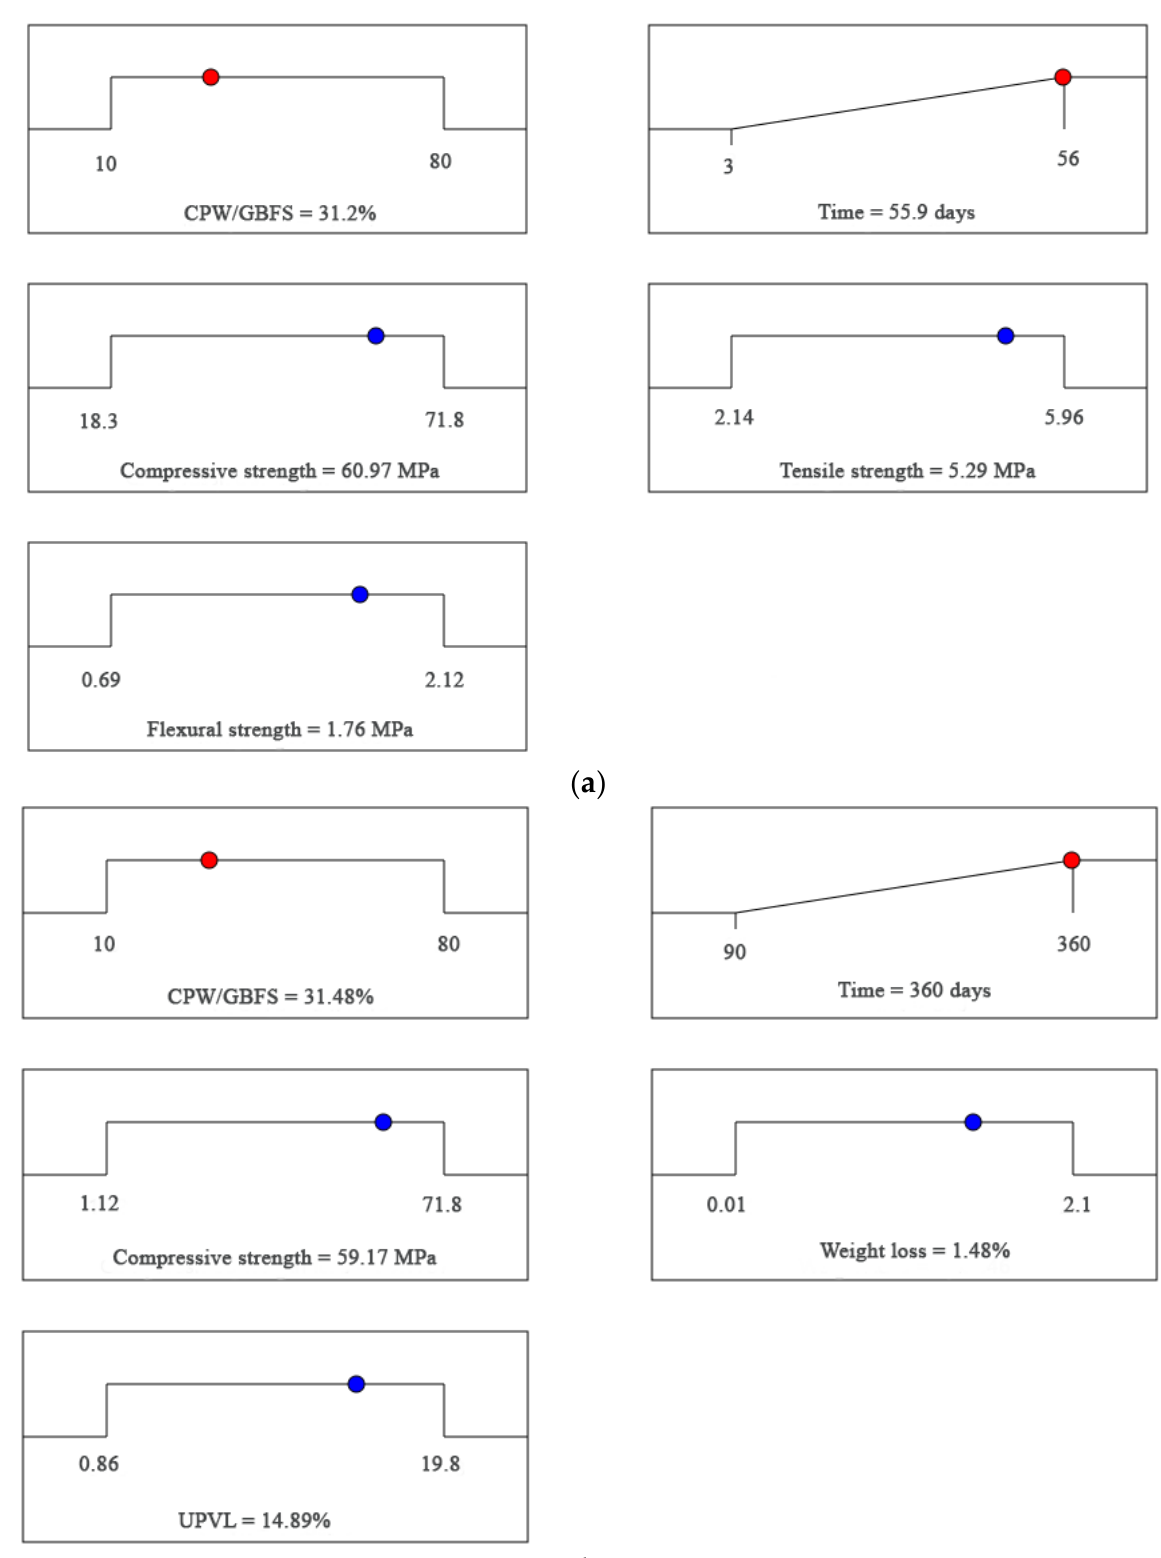
Figure 2. Optimum replacement percentage of GBFS with CWP in the aspects of ( a ) mechanical properties and ( b ) dura- bility.